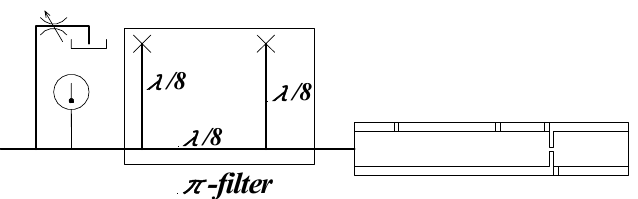
Fig.3 π -shaped filter to remove higher harmonics from waveforms of pulsating flow rate